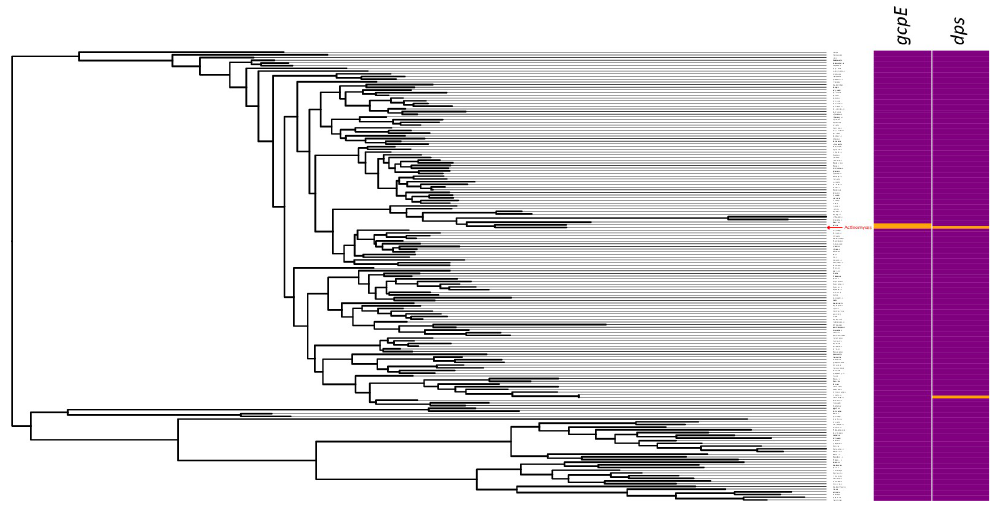
Fig 4. Genus-level broad phylogenetic distribution of the 4 MRONJ-associated genes. 16S rRNA phylogenetic tree including various genera. Strains in the tree are listed in S3 Table . In the heatmap at the right, the orange and purple indicate presence and absence of the genes,